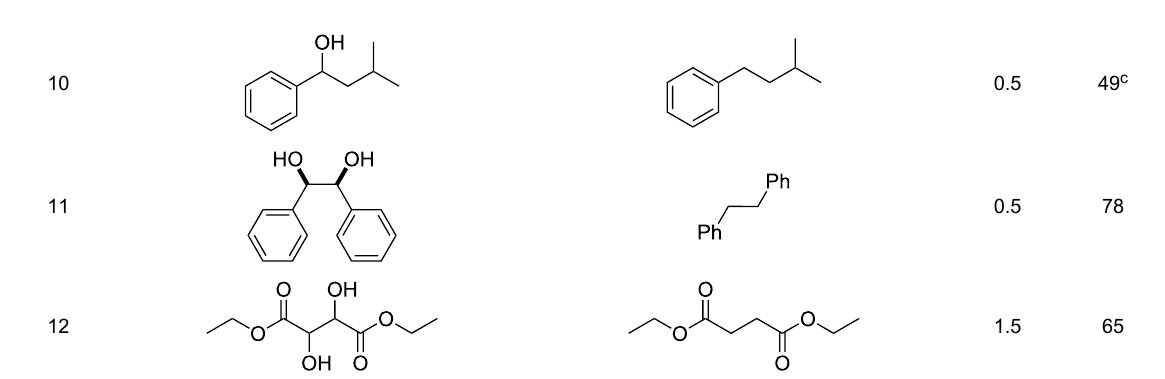
Table 1: Reduction of benzylic alcohols to the corresponding alkanes.